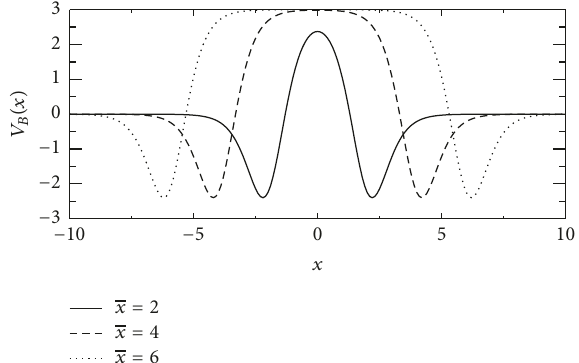
Figure5:Backgroundpotentialforthekink–antikinkpair(see(36)) for different separation